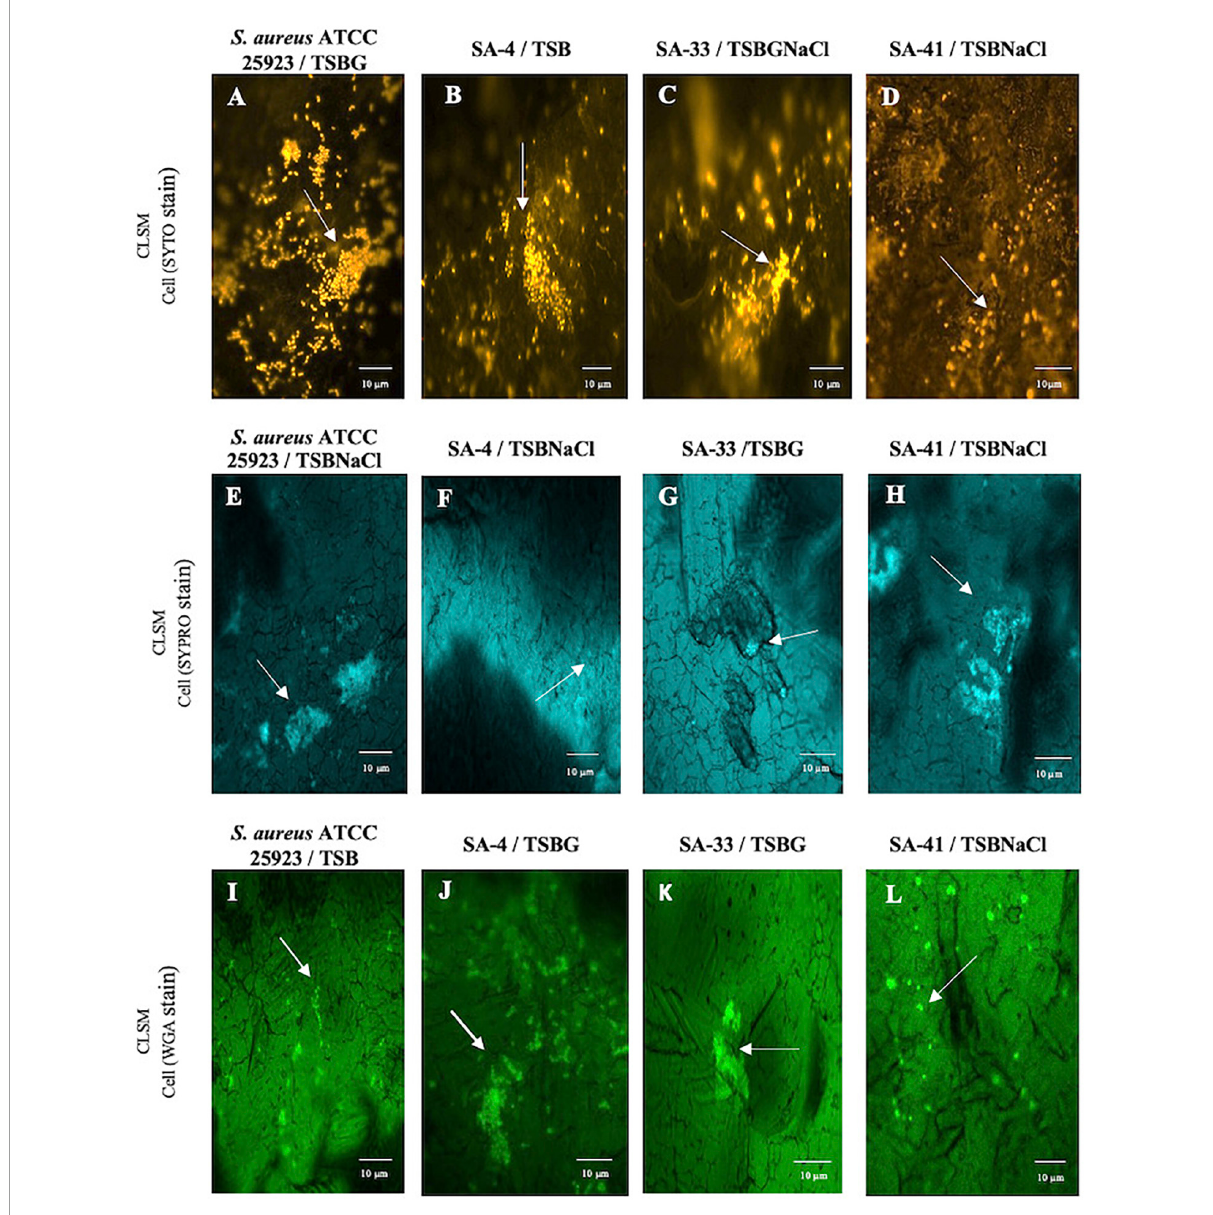
FIGURE4 Biofilm matrix structures obtained from CLSM observation of S. aureus ATCC 25923 (A,E,I) , SA-4 (B,F,J) , SA-33 (C,G,K) , and SA-41 (D,H,L) isolates from FCS on stainless steel through h of incubation in 37 ◦ C for 192 h in different medium. SA, S. aureus ; TSB, Tryptic soy broth; TSBG,